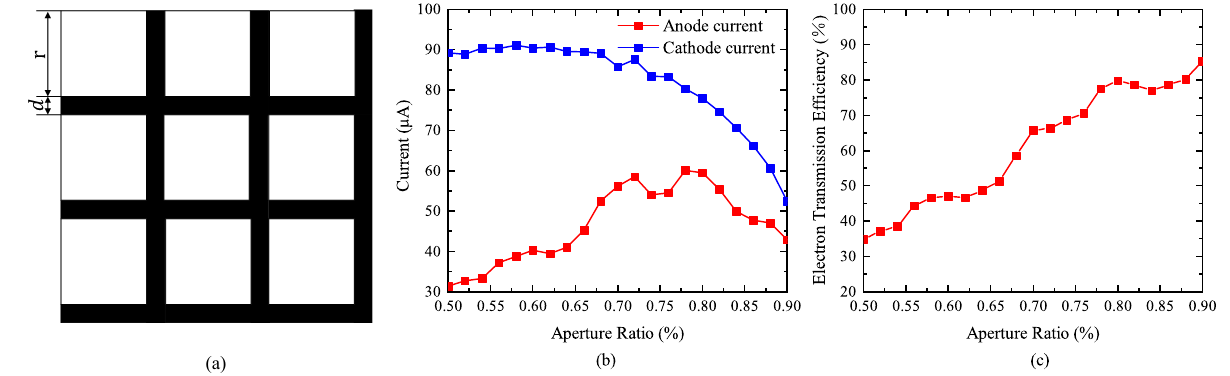
Figure 7. Relationship of aperture ratio with cathode current, anode current, and electron transmis- sion efficiency. ( a ) Quadrilateral grid structure. ( b ) Effect of aperture ratio on cathode current and anode current. ( c ) Effect of aperture ratio on electron transmission efficiency.